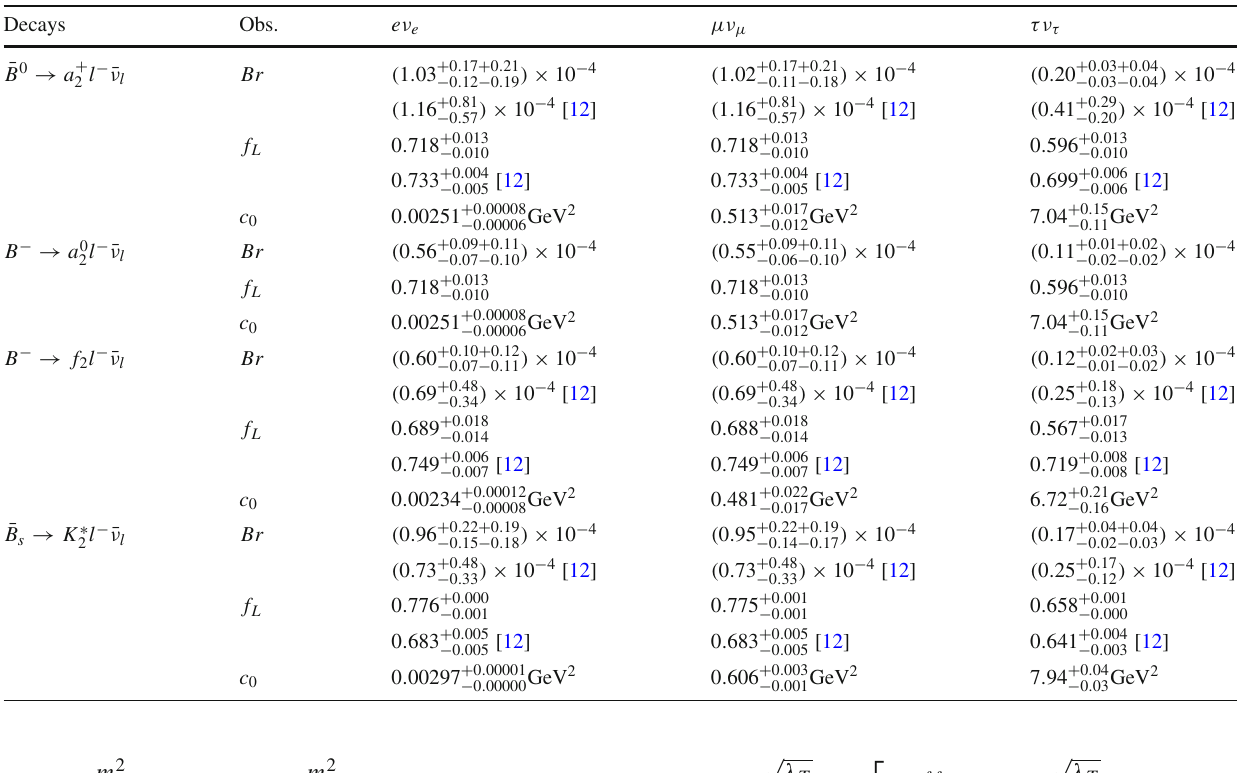
Table5 The Br , f L and c 0 forsemileptonic B ( s ) → Tl ¯ ν l decays,wherethevaluesof Br , f L calculatedbypQCD[12]arealsolistedforcomparison Decays Obs.